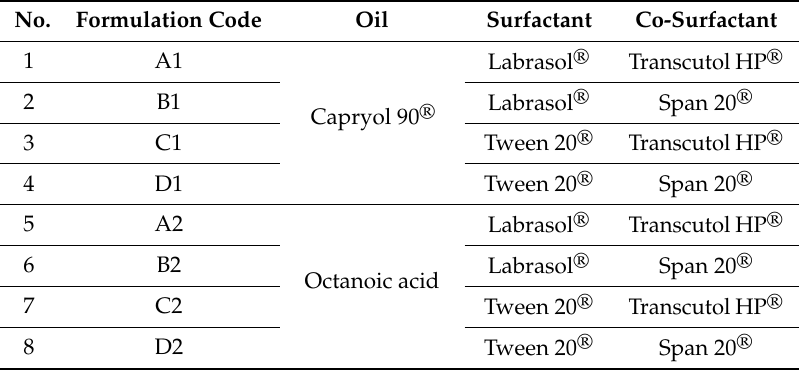
Table 2. The combination of the selected components in liquid self-emulsifying drug delivery systems (L-SEDDs)